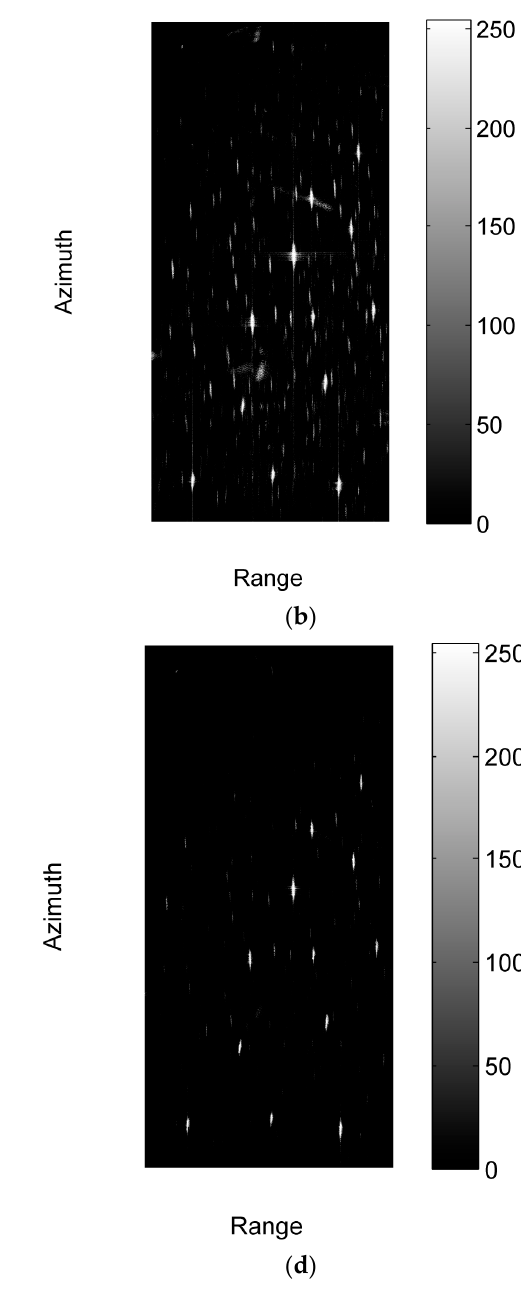
Figure 9. Comparison of detected results of various methods on sub-image #4. ( a ) Detected result of the proposed method, and the intensity of the image in dB is shown in this figure; ( b ) Detected result of the TS-SEG-CFAR method; ( c ) Detected result of the IICS method; ( d ) Detected result of the SLIC-CFAR method. Table 2. The cost times (s) of different methods on the four